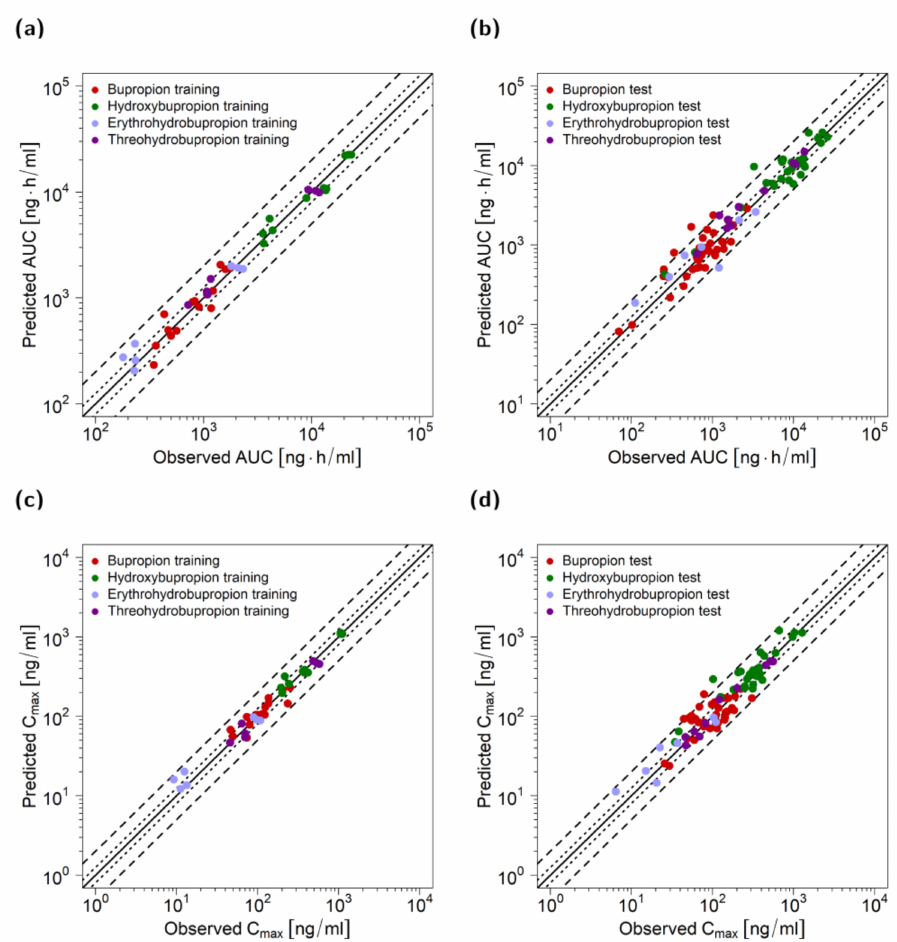
Figure 3. Goodness-of-fit plots of PK parameters for bupropion and metabolites. Predicted AUC of the training ( a ) and test dataset ( b ) as well as C max values of the training ( c ) and test dataset ( d ) compared to observed values. The solid line marks the line of identity, dotted lines indicate 1.25-fold, and dashed lines indicate 2-fold deviation. AUC: area under the plasma concentration- time curve from the time of drug administration to the time of the last concentration measurement, C max : maximum plasma